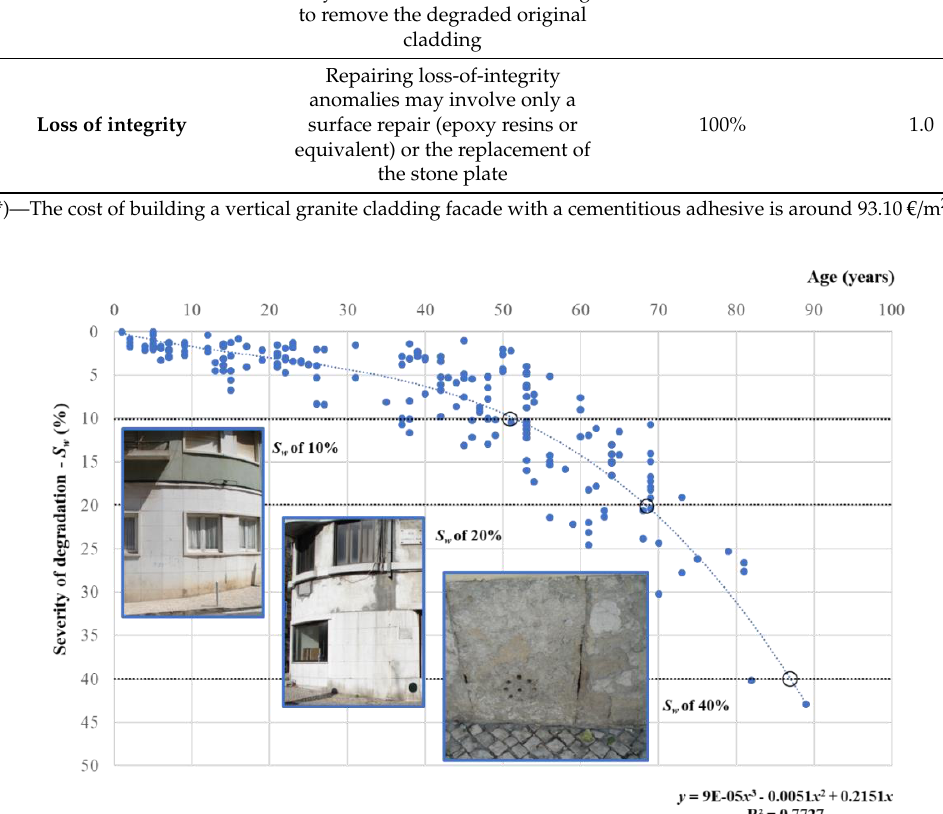
Figure 1. Degradation’s evolution using the severity of degradation level for the 142 stone claddings inspected (data sourced from Silva et al. [12]).